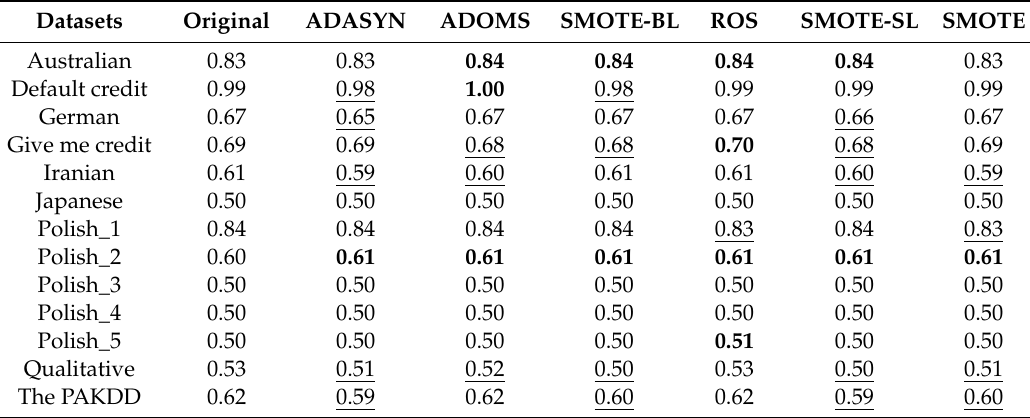
Table 15. AUC for NAC classifier after oversampling